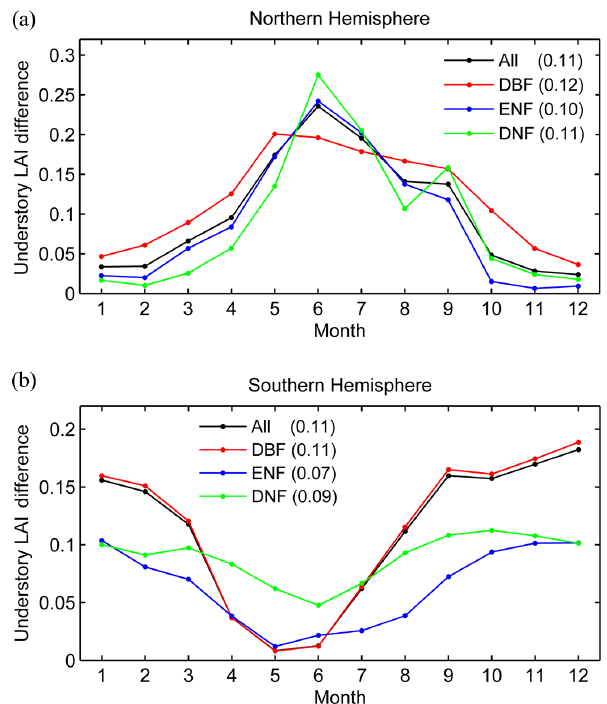
Figure 3. Differences of derived understory LAI based on the GLOBCARBON algorithm between shrub and grass in (a) the Northern Hemisphere and (b) the Southern